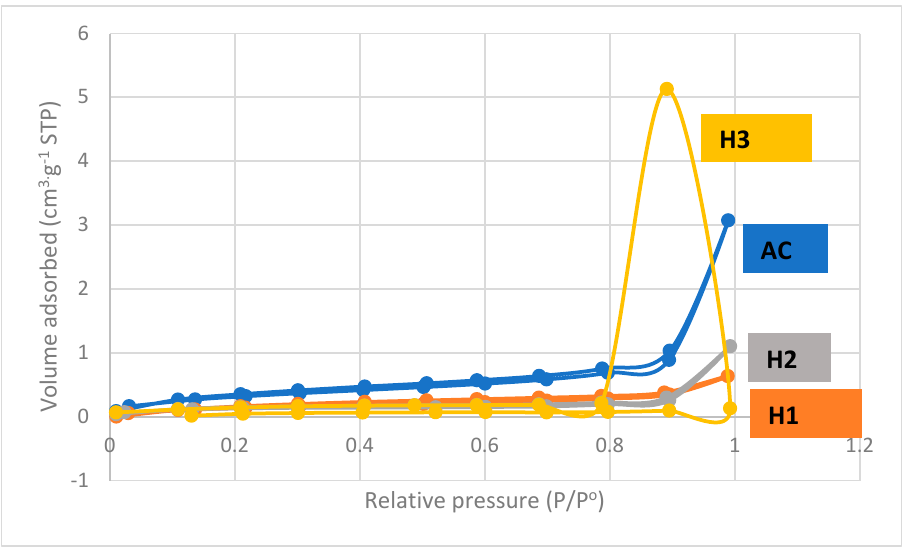
Figure 7. Plots of biogas isotherm data of unmodified membrane adsorber without HCL activation (AC) and activated membrane adsorber using g 0.5 (H1), 1 (H2), 1.5 (H3) M HCl. Table 2. Surface properties of palm empty fruit bunch membrane